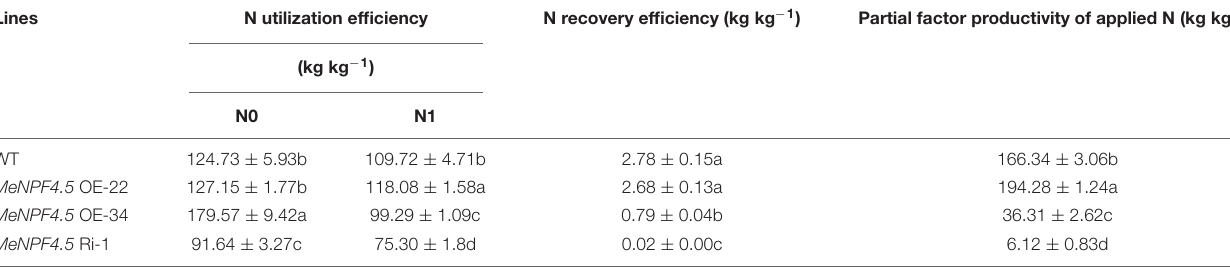
TABLE 1 | Differences in nitrogen uptake and utilization of wild-type and MeNPF4.5 transgenic cassava. Lines